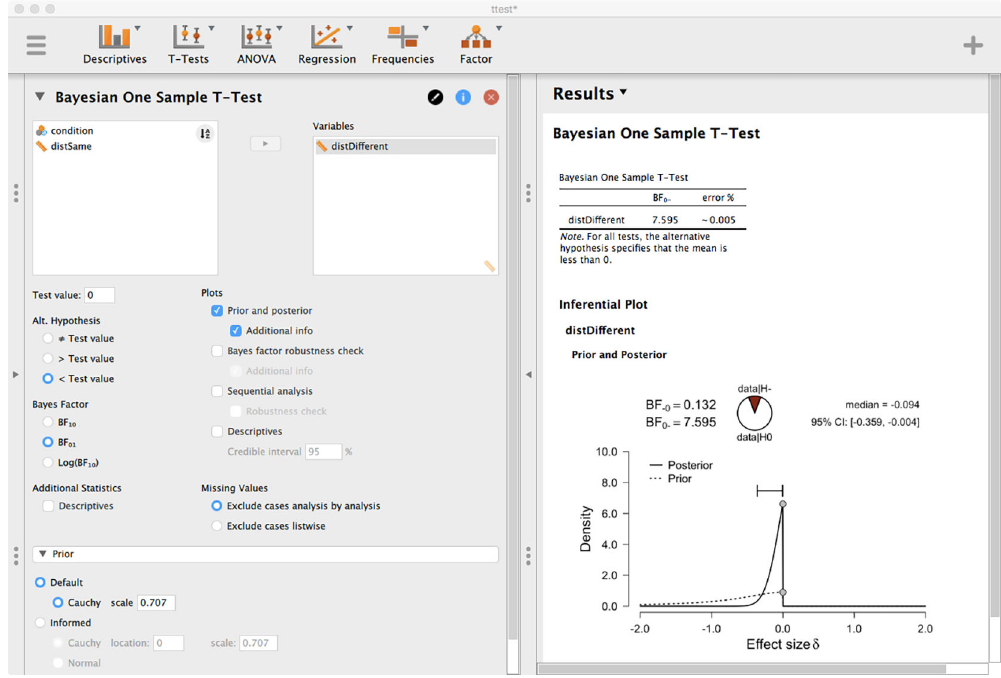
Figure 5. JASP screenshot showing a Bayesian one-sample t -test for the distDifferent